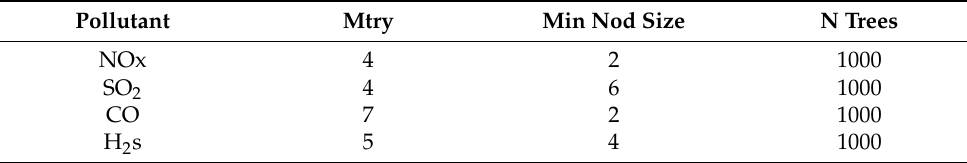
Table 2. RF model tuning parameters for each of the selected pollutants. Pollutant Mtry Min Nod Size N Trees